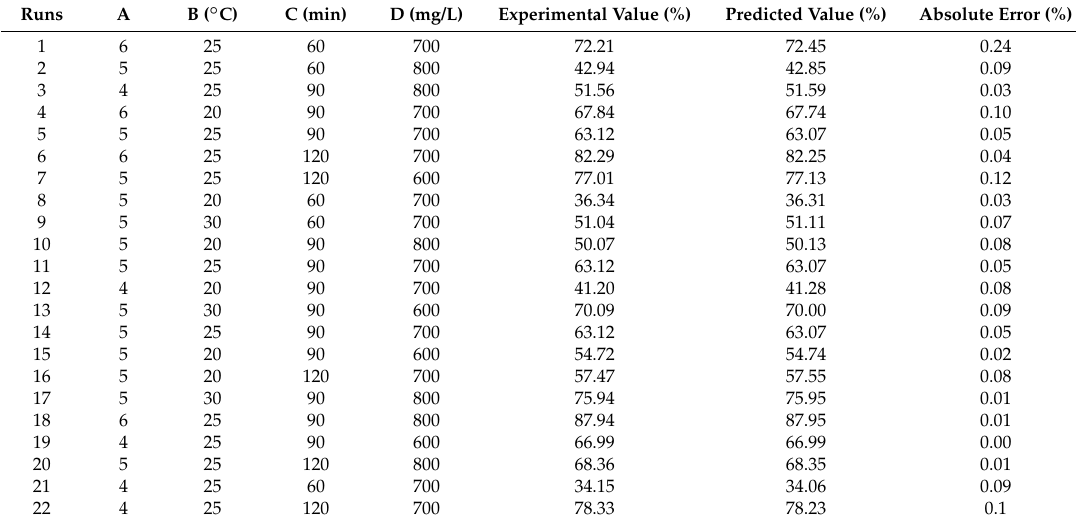
Table 3. Comparison of the removal efficiency between experimental and Back Propagation Artificial Neural Network (BP-ANN) model